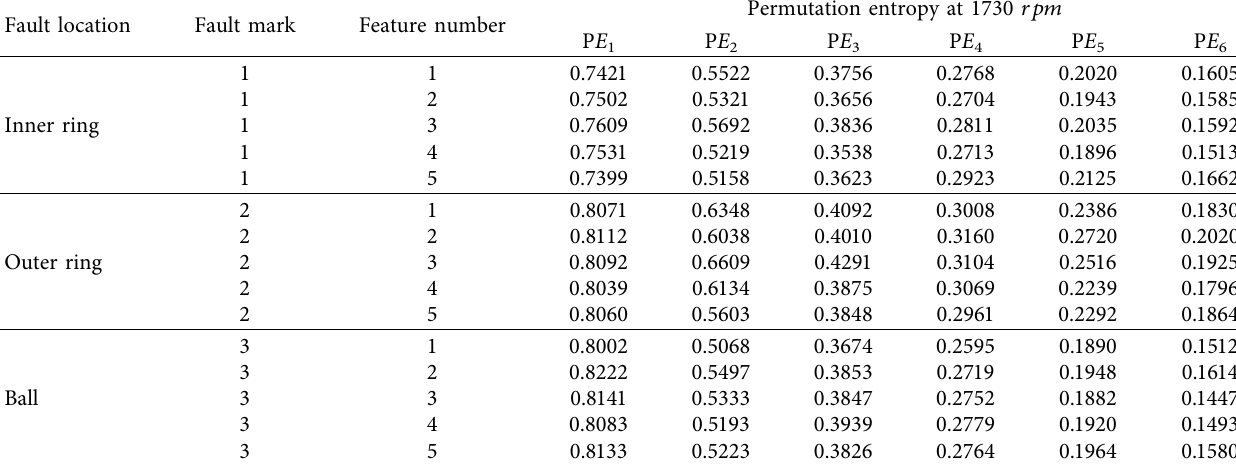
Table 5: Permutation entropy at 1730 rpm.